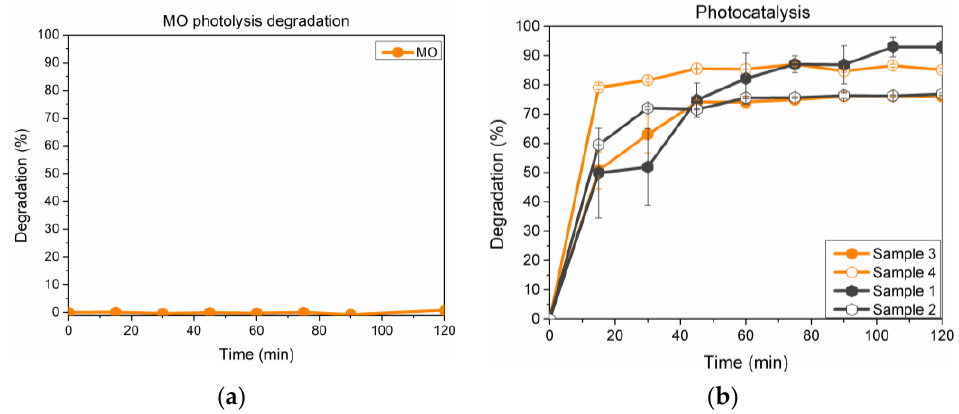
Figure 6. ( a ) MO percentage degradation due to photolysis (MO stability under irradiation); ( b ) MO percentage degradation (calculated according to Equation (1)) for investigated samples under solar simulated light.